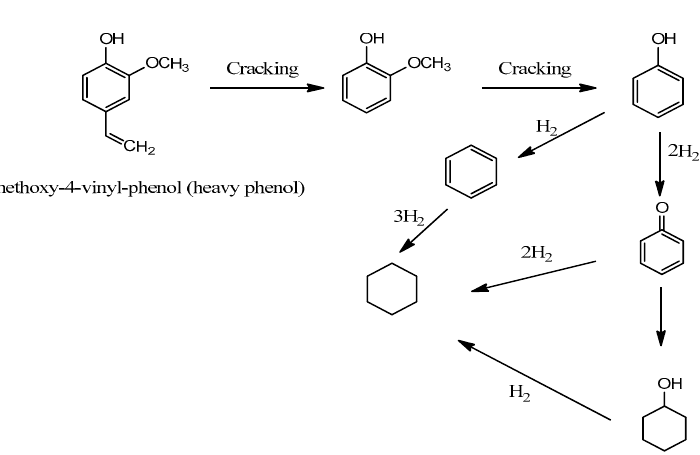
Figure 8. The suggested mechanism for converting heavy phenol to benzene and cyclohexane.